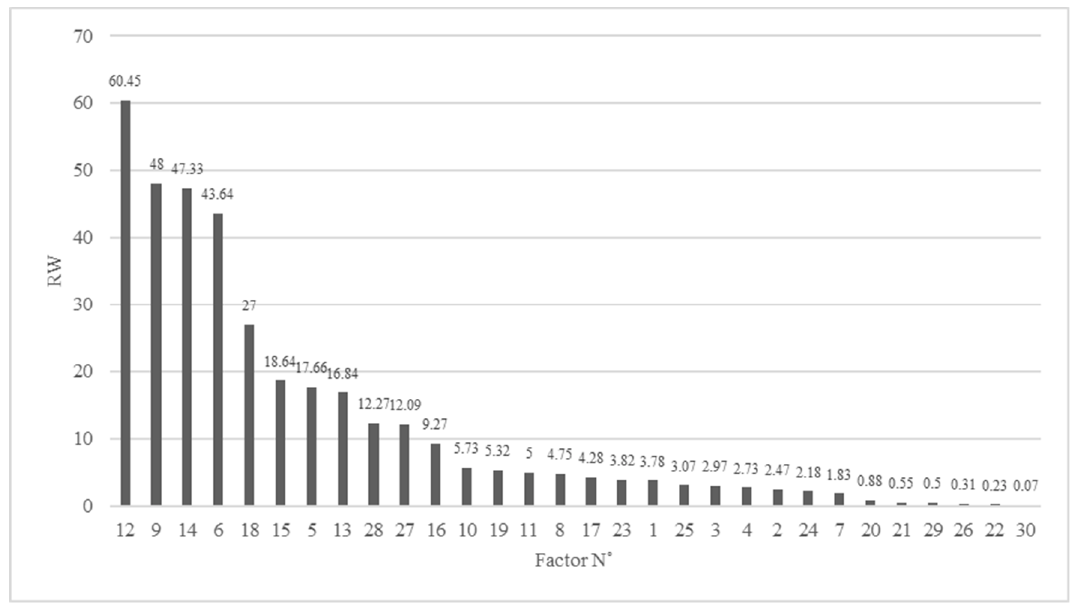
Figure 1 . Representation of the critical factors ordered by relative weight (RW). Figure 1. Representation of the critical factors ordered by relative weight